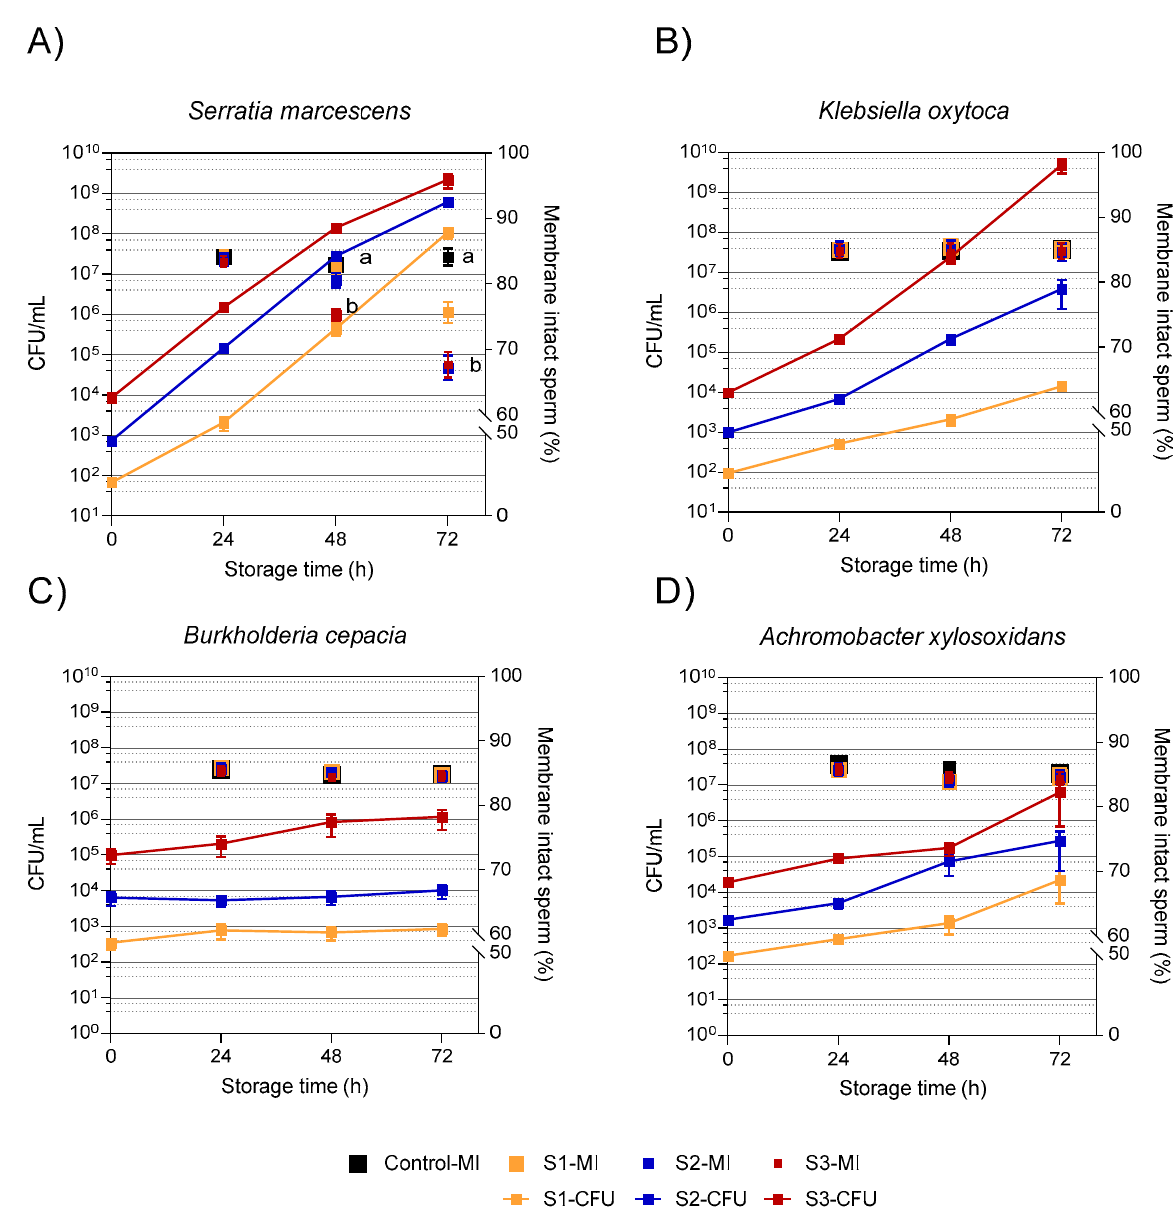
Figure 1. Bacterial growth (CFU/mL) and sperm membrane integrity in extended semen samples spiked with four different multidrug-resistant bacterial species at three different levels: S1, ~10 2 CFU/mL; S2, ~10 3 CFU/mL; and S3, ~10 4 CFU/mL. The samples extended in Beltsville Thawing So- lution were stored at 17 °C for 72 h. Sperm data are means and SEM ( S. marcescens : n = 6; other bacteria: n = 8). Bacterial counts in controls were below the detection limit (<10 1 /mL) throughout storage. a, b: Different lowercase letters indicate differences between membrane-intact sperm (%, MI) at a given storage time point ( p < 0.05). ( A ) Serratia marcescens ( B ) Klebsiella oxytoca ( C ) Burkhol- deria cepacia ( D ) Achromobacter xylosoxidans .